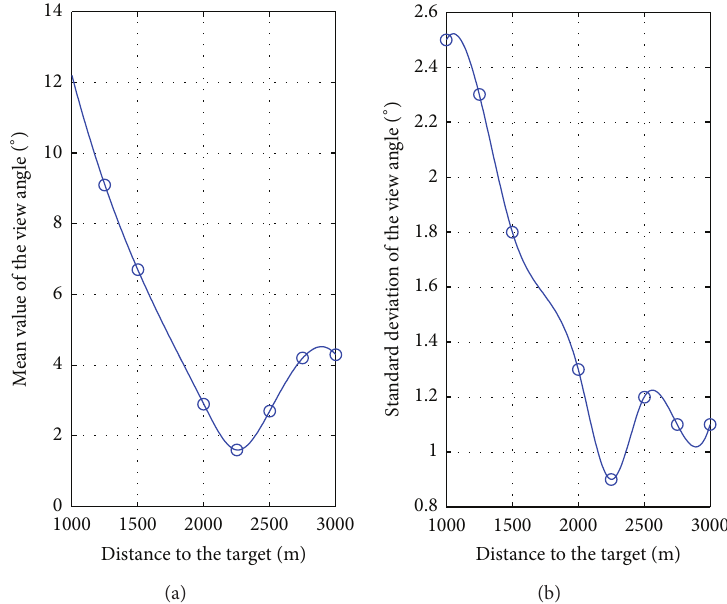
Figure 18: Cubic spline interpolation curve results (moving target).